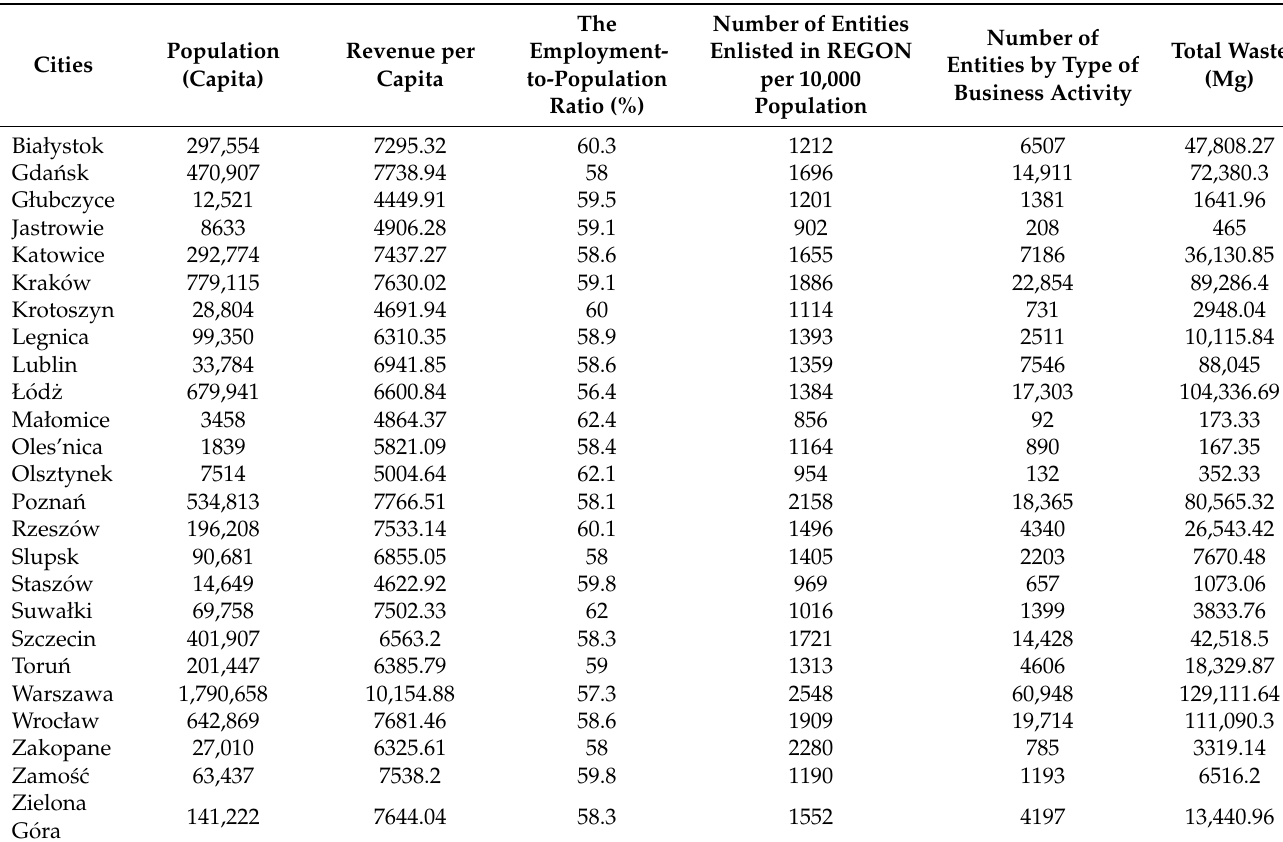
Table 1. Description of the